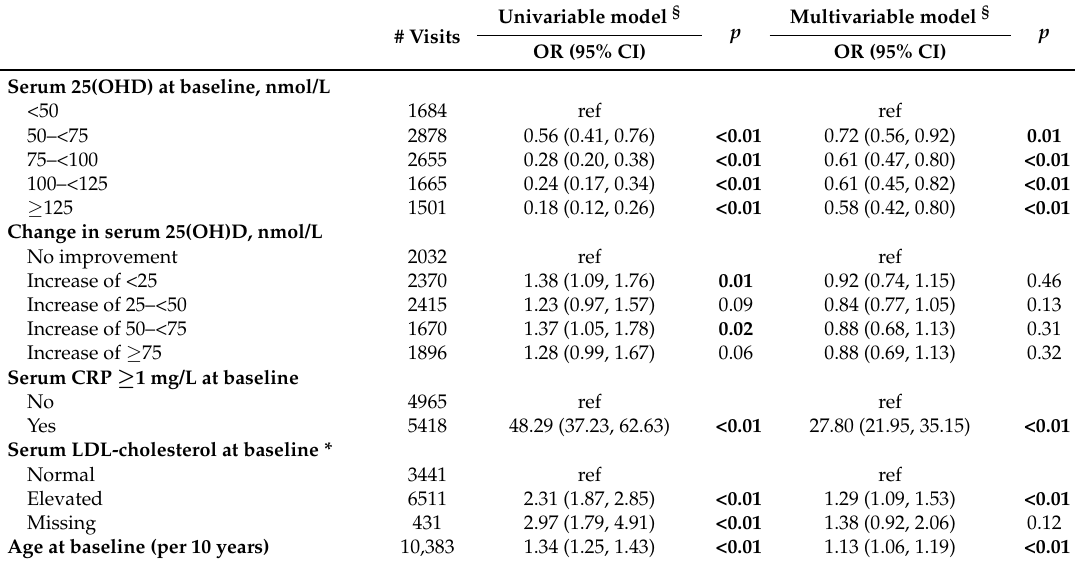
Table 2. Risk for elevated C-reactive protein concentration ( ≥ 1 mg/L) at follow-up among 6755 participants with a total of 10,383 follow up